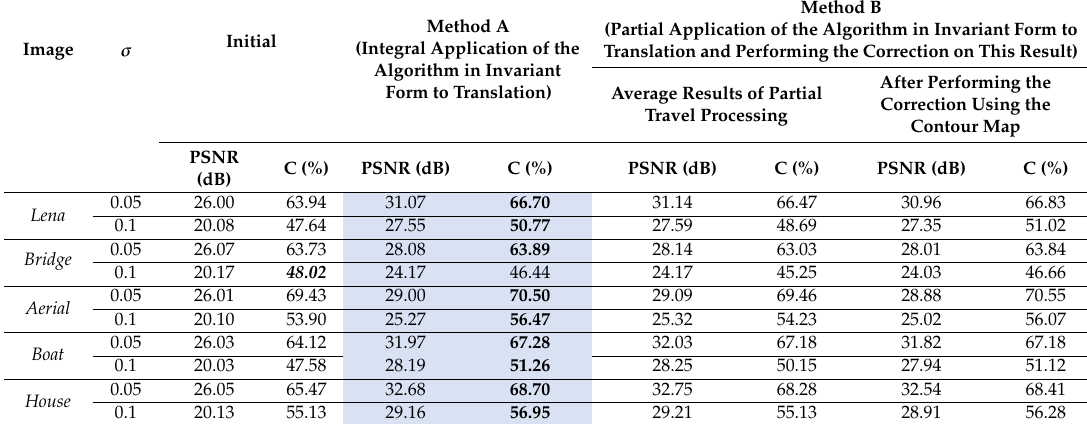
Table 5. Application of the proposed algorithm in invariant approach to displacement, in the two approaches discussed. Four circular trips were made. The test images were 256 × 256 pixels and were degraded with white Gaussian additive